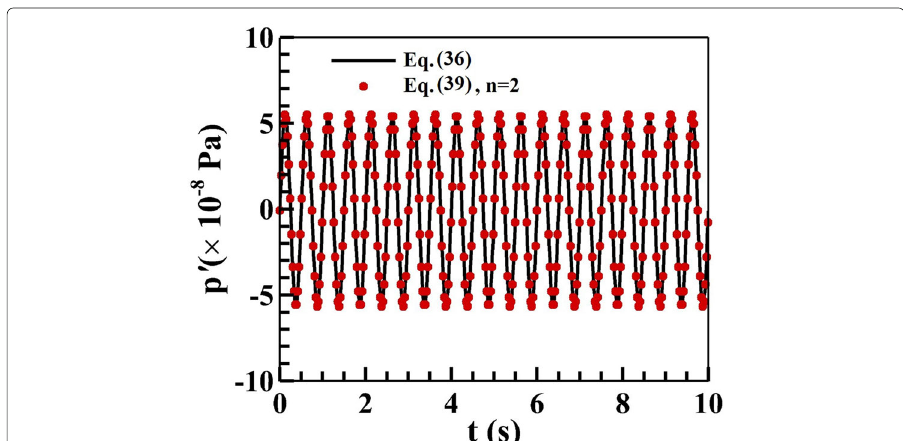
Fig. 10 Acoustic pressure computed by using the acoustic pressure formulation (Eq. (36)) and the approximated acoustic pressure formulation (Eq.